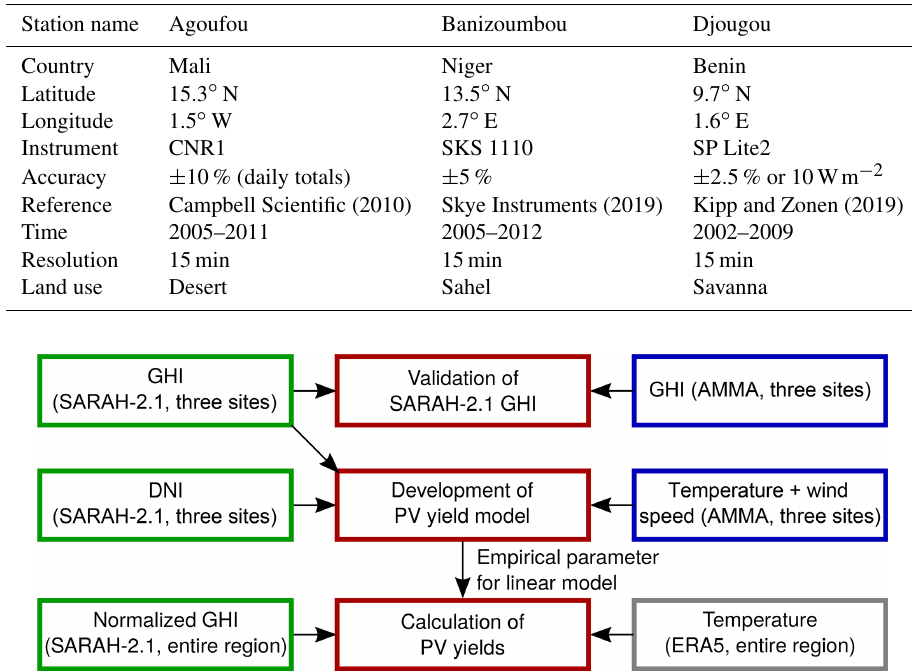
Table 1. Information on ground-based measuring sites.